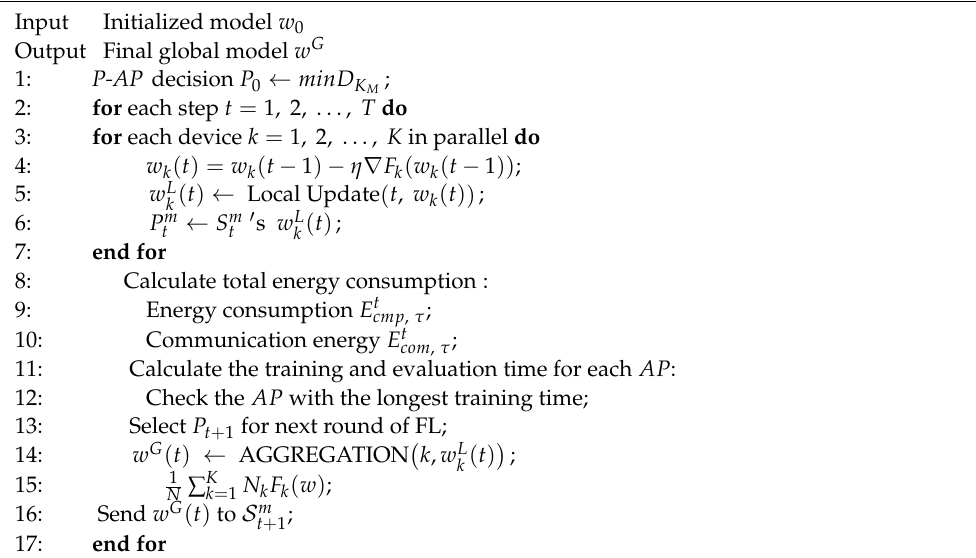
Algorithm 1: Proposed fairness-based multi-AP coordination